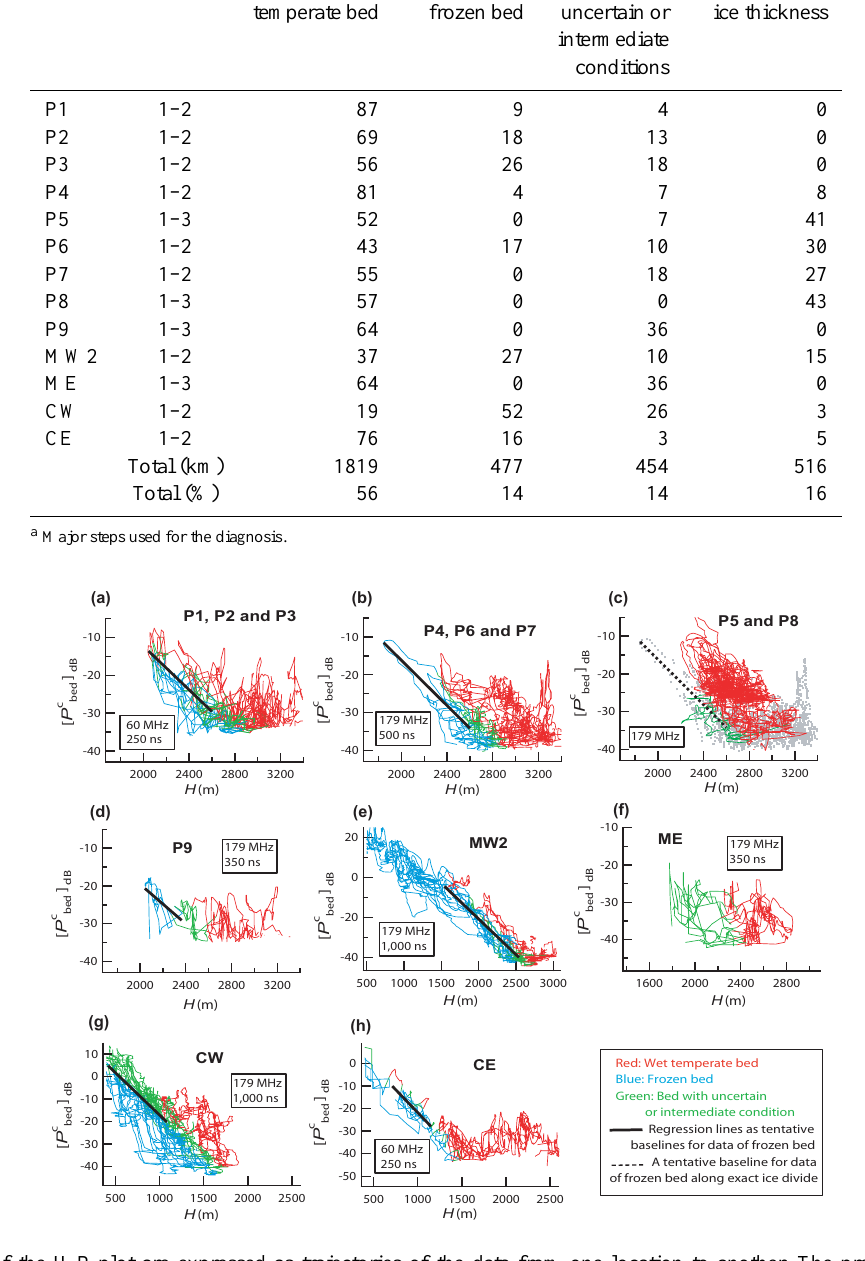
H > ∼ 2800 m. Frozen bed conditions only occur